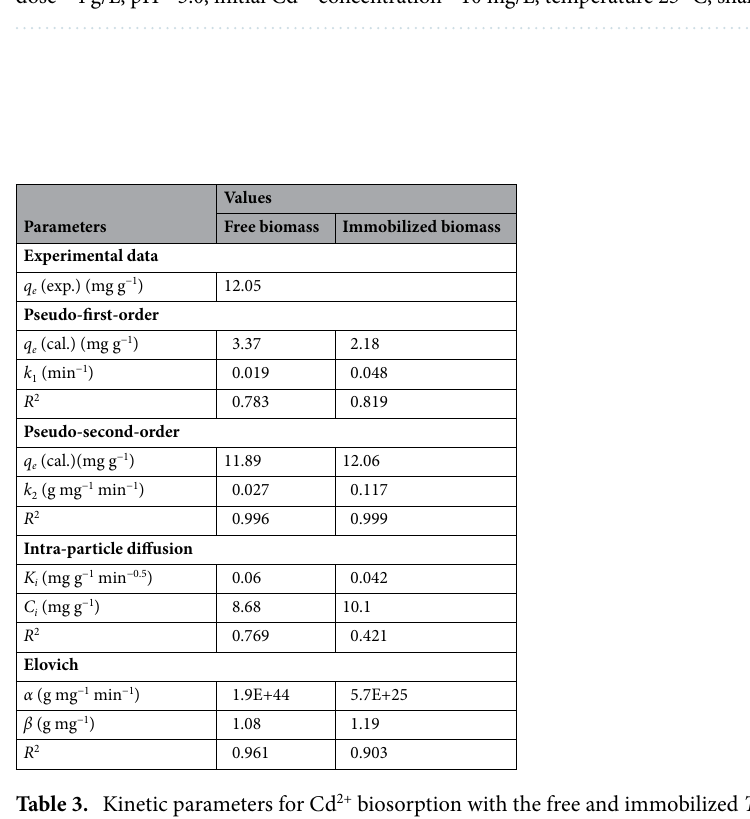
Figure 4. ( A ) Pseudo-first-order, ( B ) pseudo-second-order, ( C ) Intra-particle diffusion, and D) Elovich kinetic models of Cd 2+ ion biosorption by the freely suspended and Ca-alginate-immobilized T. ornata cells (biosorbent